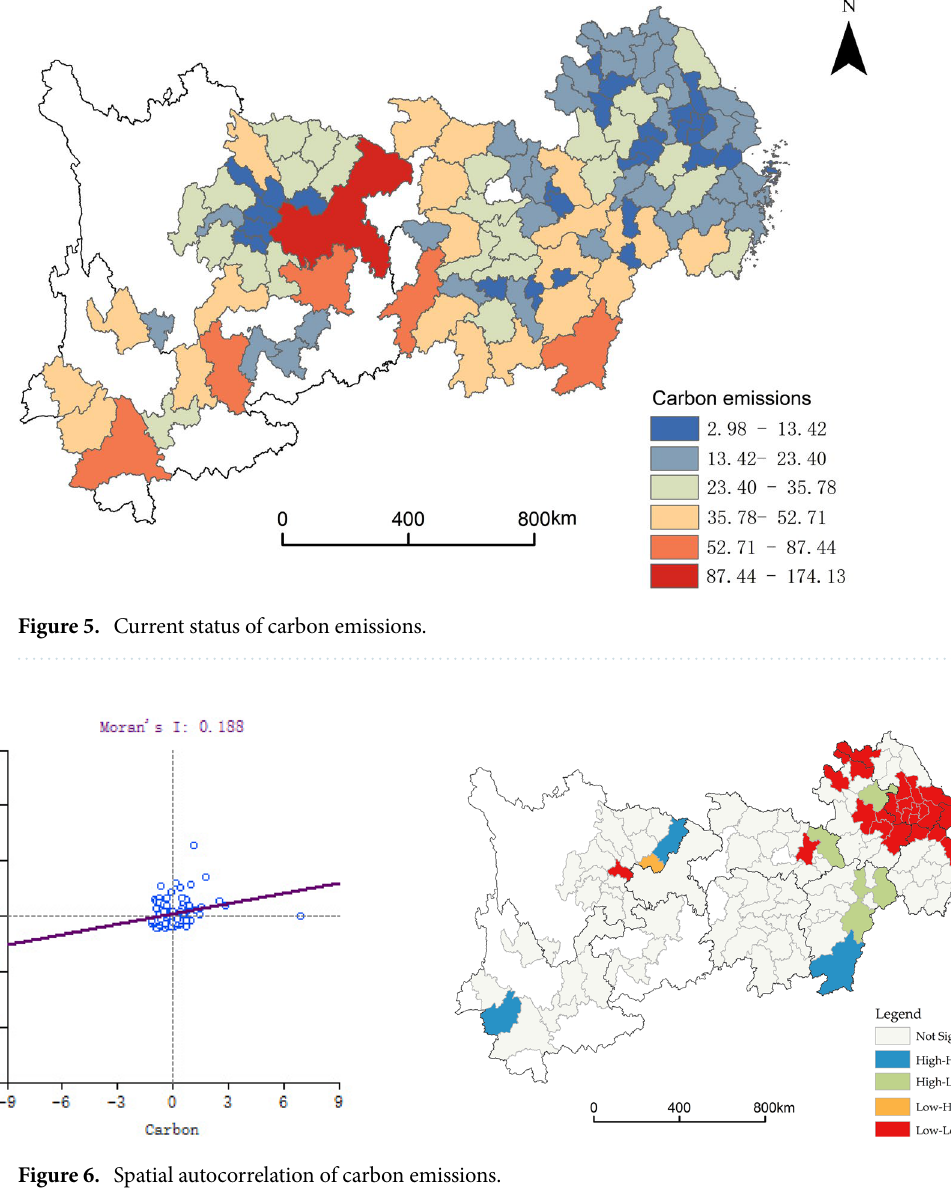
Figure 6. Spatial autocorrelation of carbon